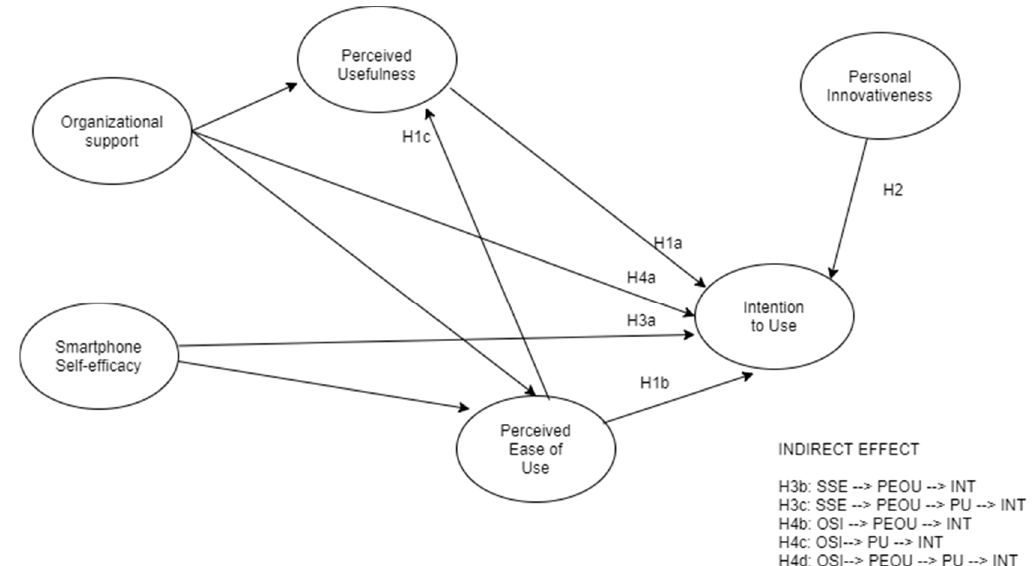
Figure 1. Hypothesized model. Note. SSE = smartphone self-efficacy; PEOU = perceived ease of use; INT = intention to use; PU = perceived usefulness; OSI = organizational support for innovation.